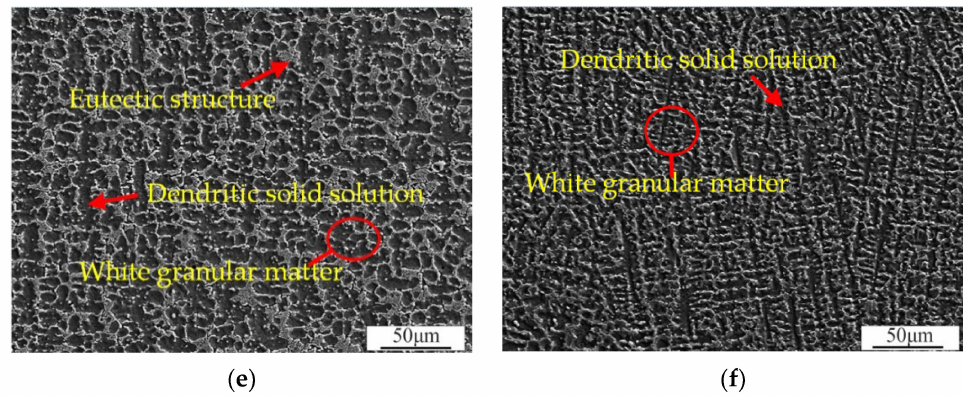
Figure 12. The SEM microstructure of the cross-section of the cladding layer in the middle: ( a ) 1#; ( b ) 2#; ( c ) 3#; ( d ) 4#; ( e ) 5#; and ( f ) 6#.